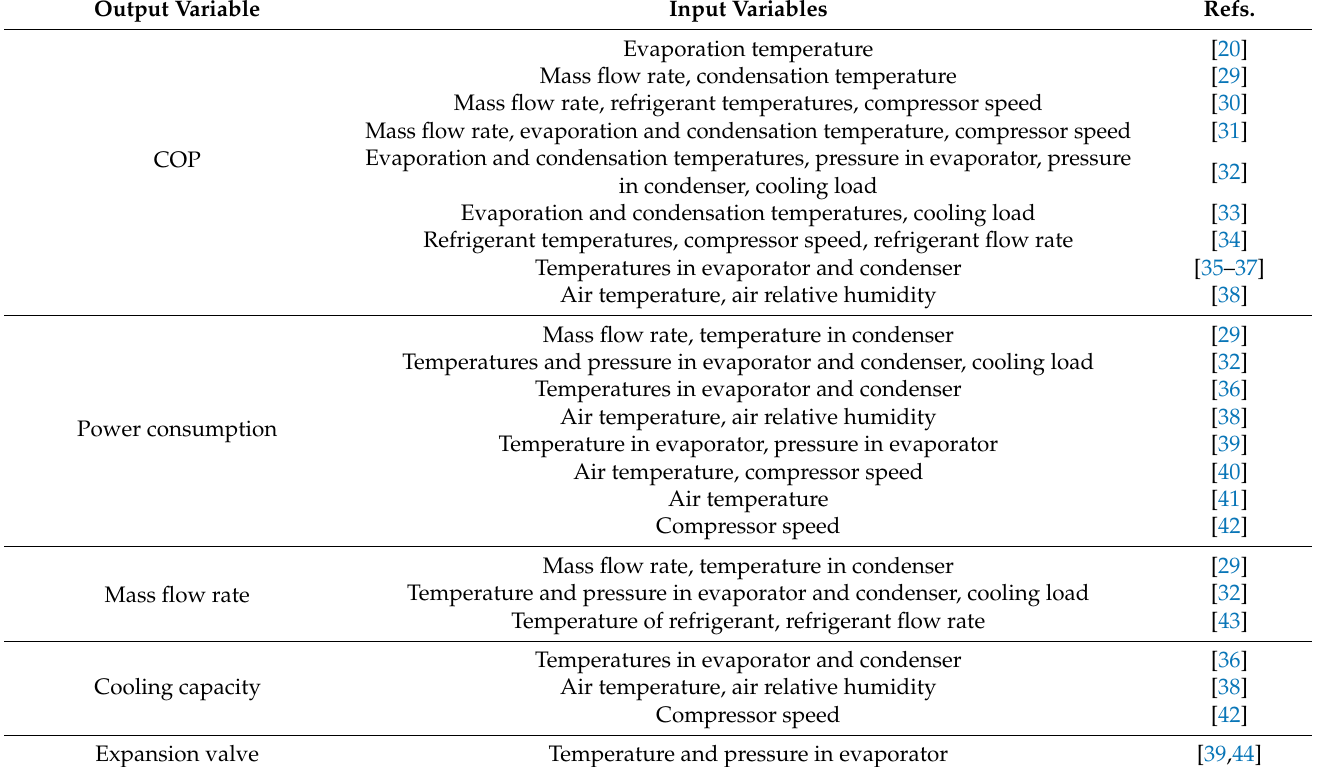
Table 2. Main input/output variables used in ANN modeling of refrigeration